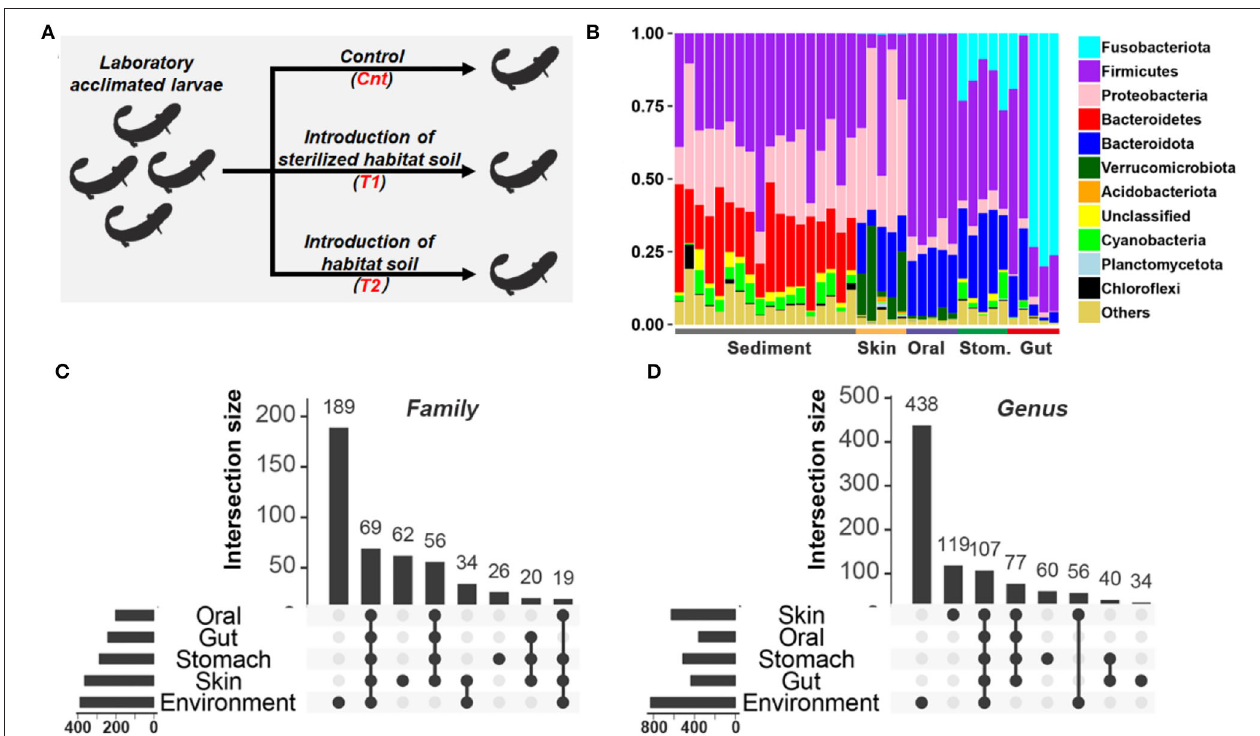
FIGURE 1 | Comparison of microbiota between habitat river sediments and captive giant salamander. (A) Experimental design. (B) The relative abundance of the bacterial taxon in the habitat river sediments and captive giant salamander at the phylum level. (C,D) The number of shared and unique bacterial families (C) or genera (D) between river sediments and commensal microbiota. The horizontal bars represent the family or genus numbers of each source, while the vertical bars denote the numbers of their shared or unique bacterial